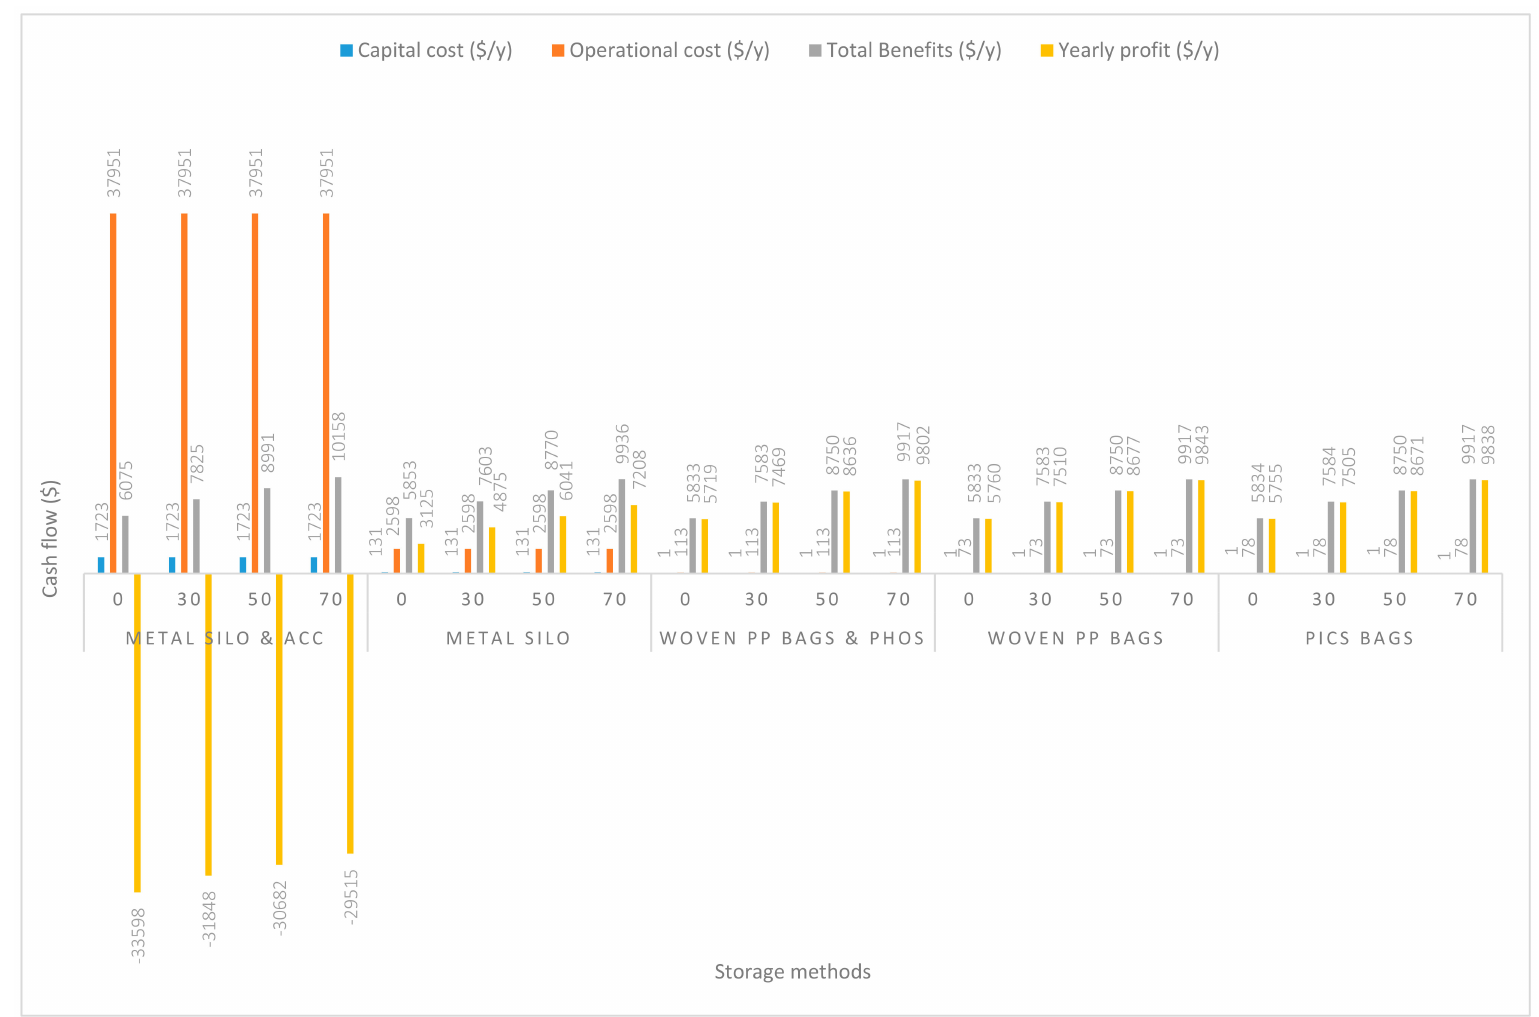
Figure 4. Annual capital and operational costs (US dollars), total annual benefits and profits (US dollars) for each handling / storage method at 28 Mg / y handling capacity for 0%, 30%, 50%, and 70% grain price